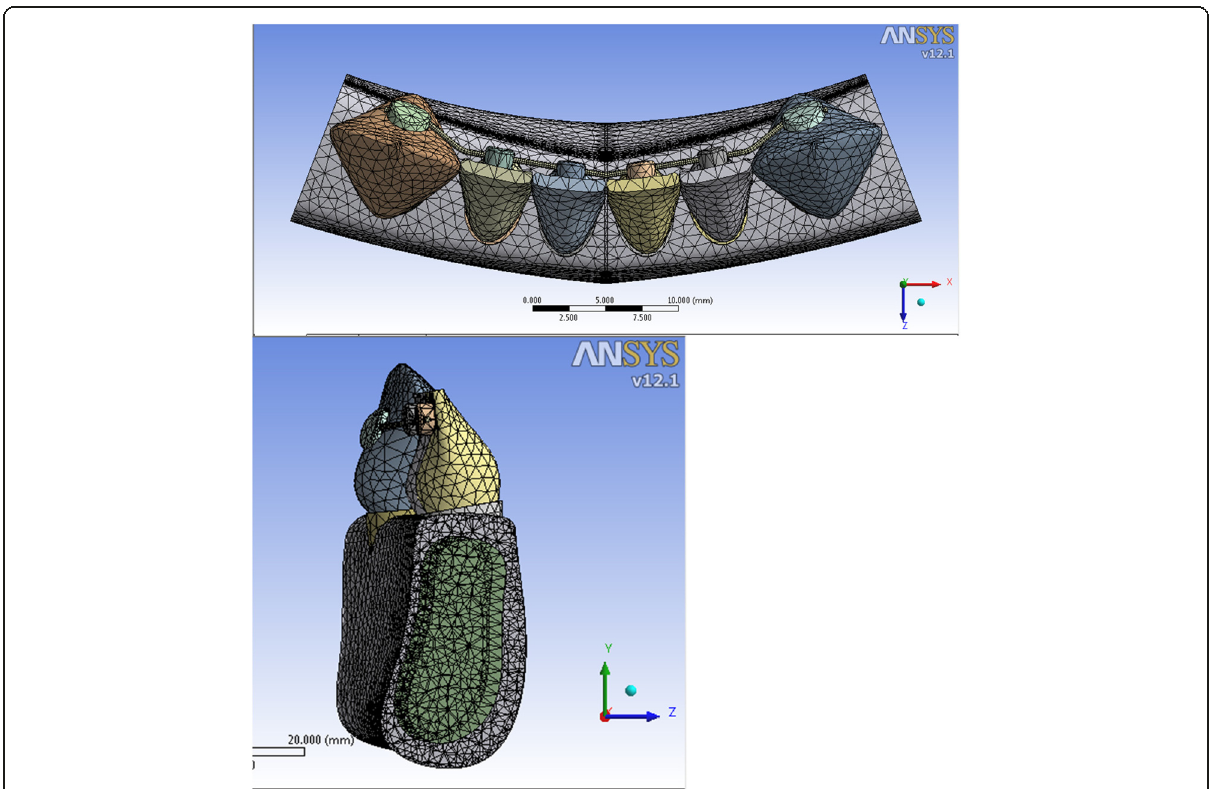
Fig. 1 Meshed model 1 showing the inclination of the anterior teeth at 80° to the horizontal